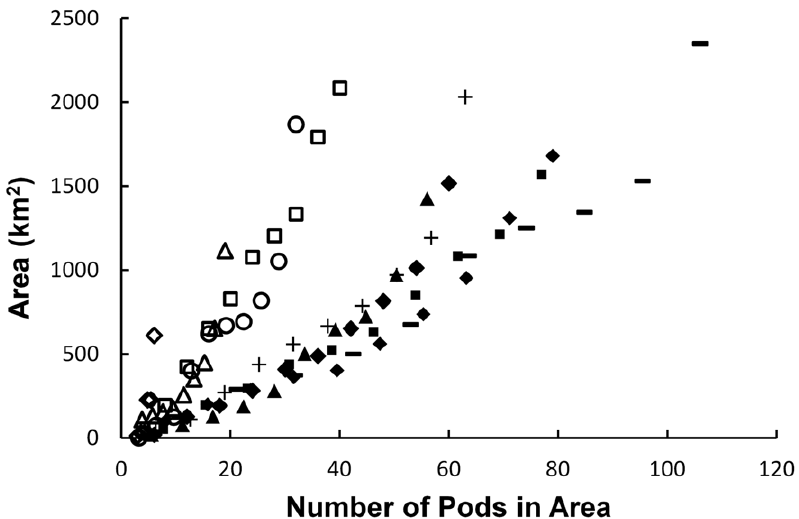
Figure 2. The area occupied by an increasing number of pods nearest to the centre of aggregation. The minimum polygon area (convex hull area) around whale pods was repeatedly calculated for each survey flight to include increasing number of pods closest to the centre of aggregation, starting at the nearest 10% until all pods were encompassed by the polygon. A scatter plot of these changes in area occupied reveals two patterns in area use; the first group of flights are indicated by open symbols ( n flight 4, e flight 5, # flight 6, % flight 8) and the second group by closed symbols ( ¤ flight 1, & flight 2, m flight 3, + flight 7, – flight 9, ¤ flight 10).